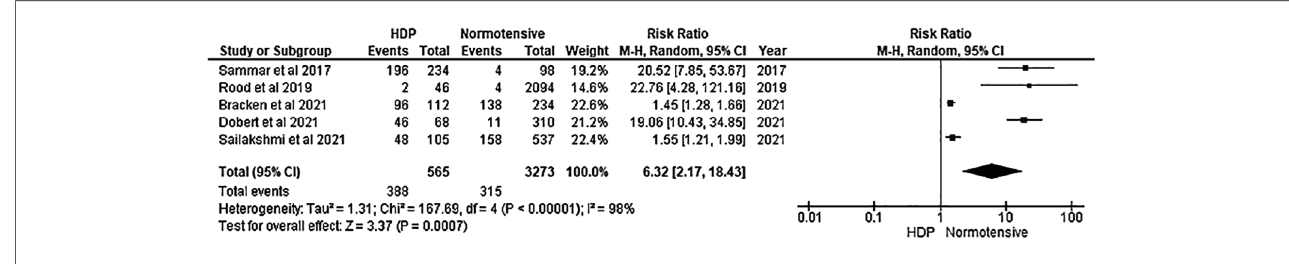
FIGURE 2 Forest plot indicating the effectiveness of Congo Red Dot Paper Test.